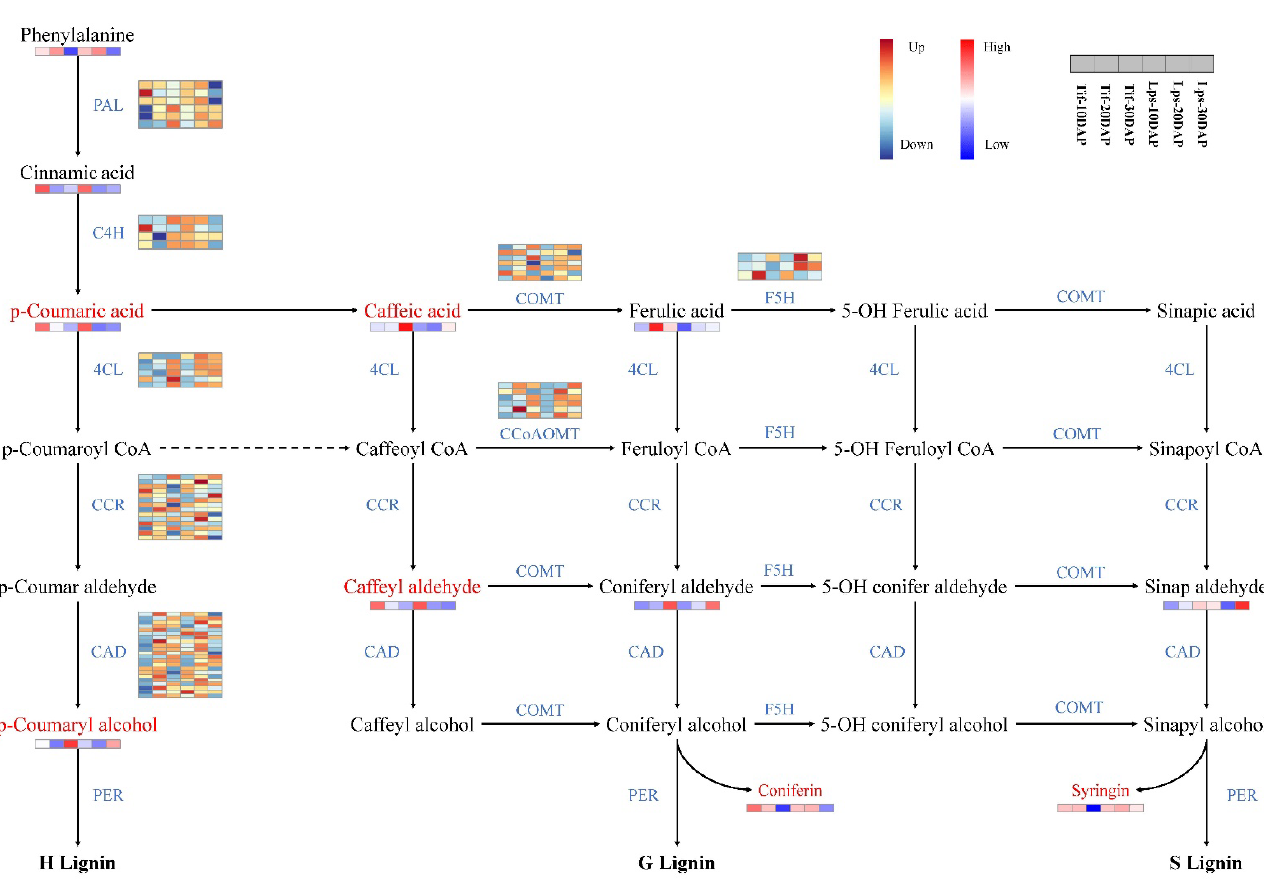
Figure 6. Transcriptomic and metabolic shifts in the phenylpropanoid biosynthesis pathway in Tif and Lps during the process of pod development. DAMs involved in the pathway are marked in red, and the relative content of each metabolite is displayed in the form of a heat map. The color scale indicates low (blue) to high (red) contents. For genes, heat maps represent the expression levels of DEGs in Tif and Lps; each row corresponds to a DEG, and the expression levels are shown in dark blue (downregulated) and dark red (upregulated).